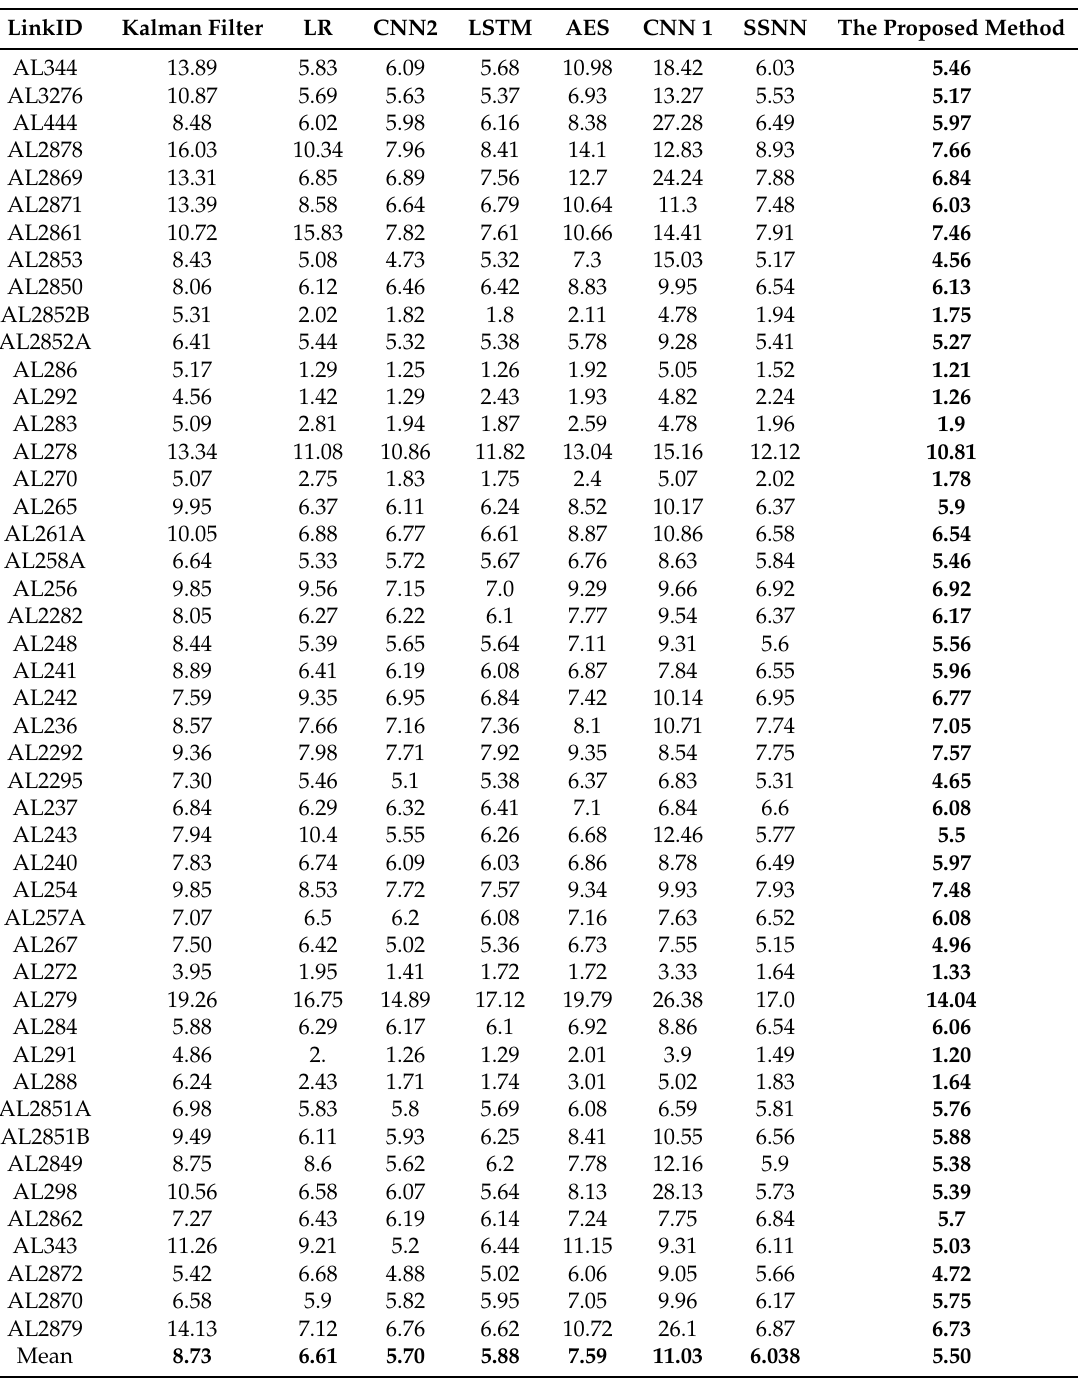
Table 6. Experimental results of the proposed method and the baseline methods on individual links in terms of MAPE. The best results in the table appear in